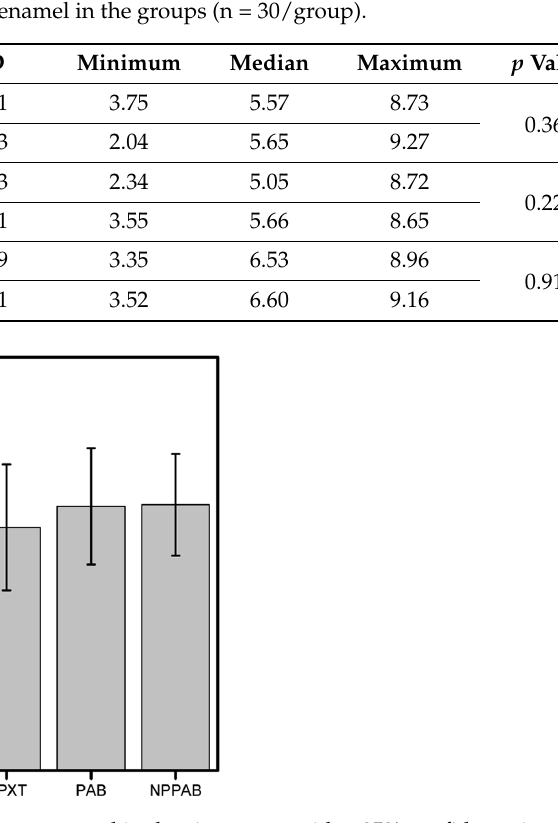
Figure 2. The mean SBS of the bracket to enamel in the six groups with a 95% confidence interval.